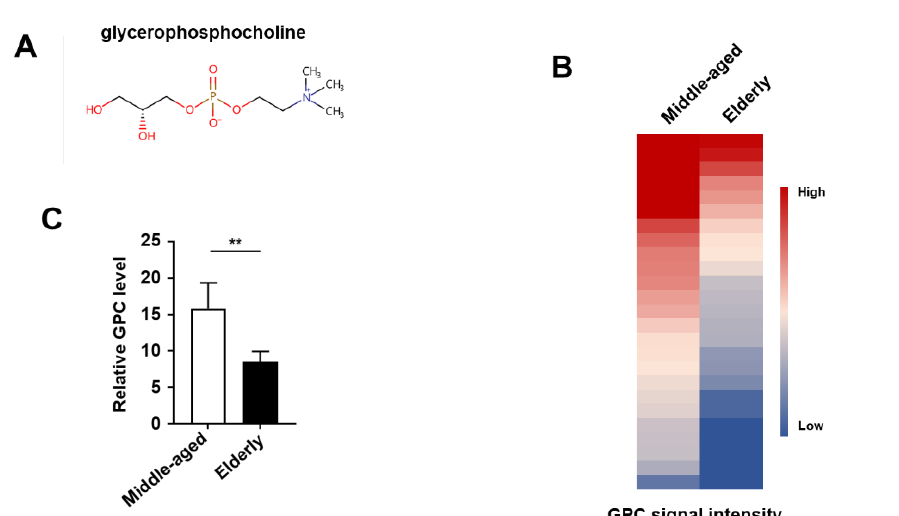
Figure 1. Plasma GPC level declines during aging. ( A ) Scheme of chemical structure for GPC. ( B ) Heat-map analysis of GPC signal intensity in plasma samples from middle-aged ( n = 25) and elderly people ( n = 25). Each column in the heat map represents one age group, and each row represents one sample from the middle-aged or elderly group. Plasma GPC level was detected by UPLC-ESI-MS/MS. ( C ) The relative abundance of plasma GPC in each group. ** p ≤ 0.01; by unpaired t test. Values are mean ± s.e.m.